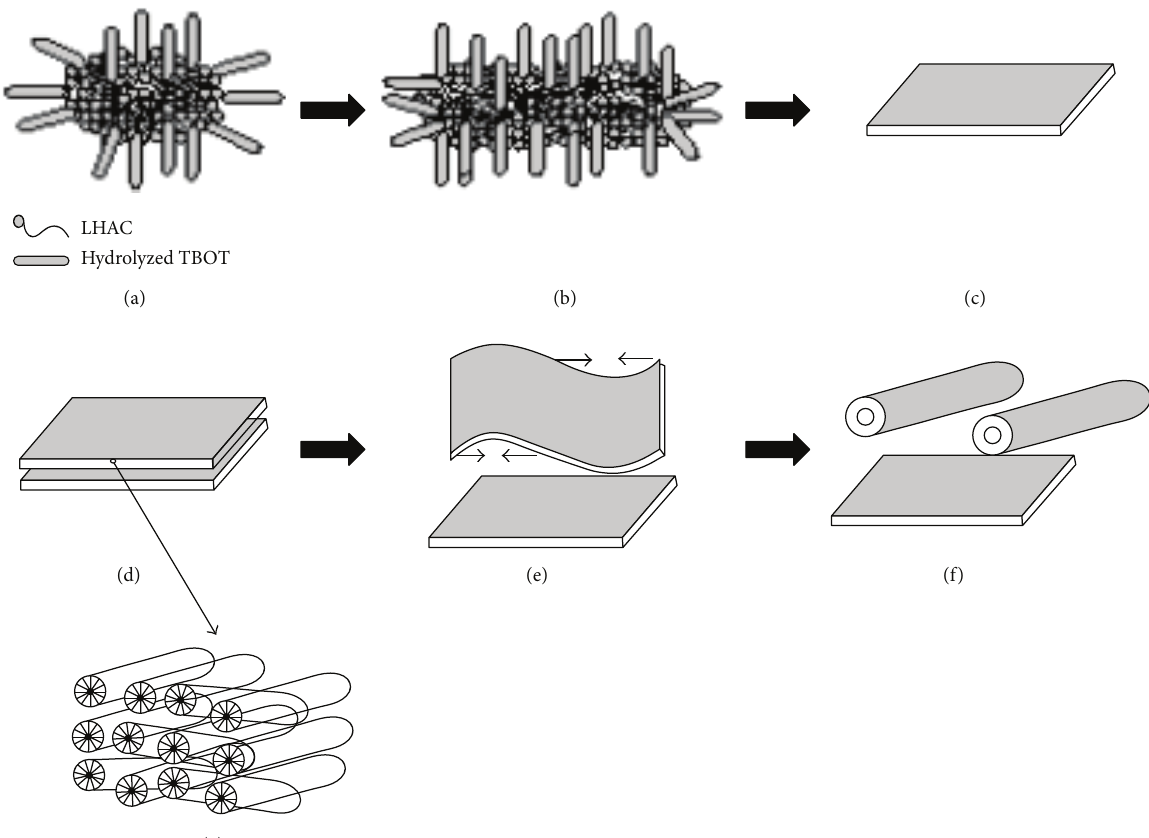
Figure5:Proposedformationprocessesofthemicrotubules.(a)GlobularaggregatescontainingLAHCandhydrolyzedTBOT.(b)Aggregates enlarged in size. (c) and (d) Mixed lamellar liquid-crystal phase membrane containing rodlike micelles. (e) Charge imbalance resulting in membrane curvature. (f) Further bending into tubules. (g) Random and segregated arrangement of rod micelle layers which are separated by bilayers of LAHC from bulk solution